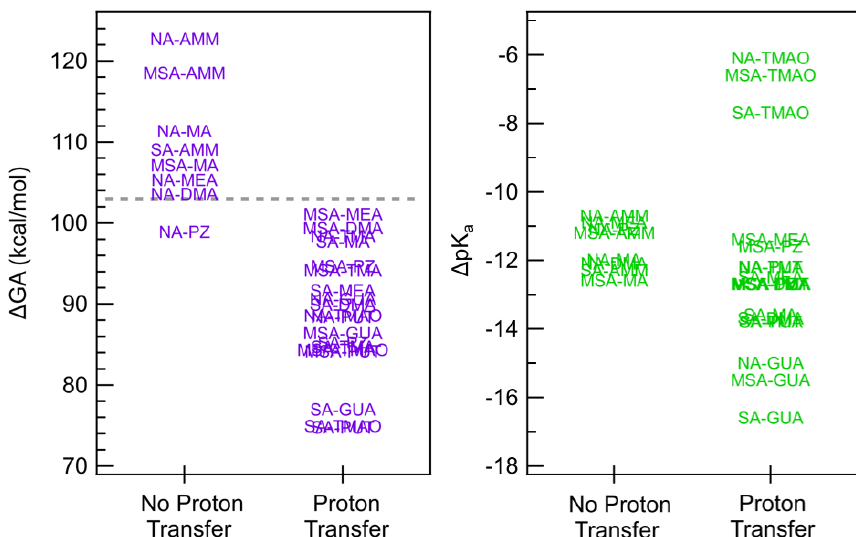
Figure 5. (cid:49) GA and (cid:49) p K a values separated based on whether the heterodimer structure exhibits proton transfer. The dashed gray line on the (cid:49) GA graph at 103kcalmol − 1 shows the cutoff point for proton transfer.